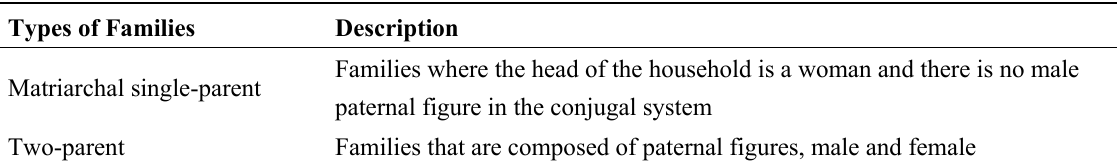
Table 2. Types of usual families